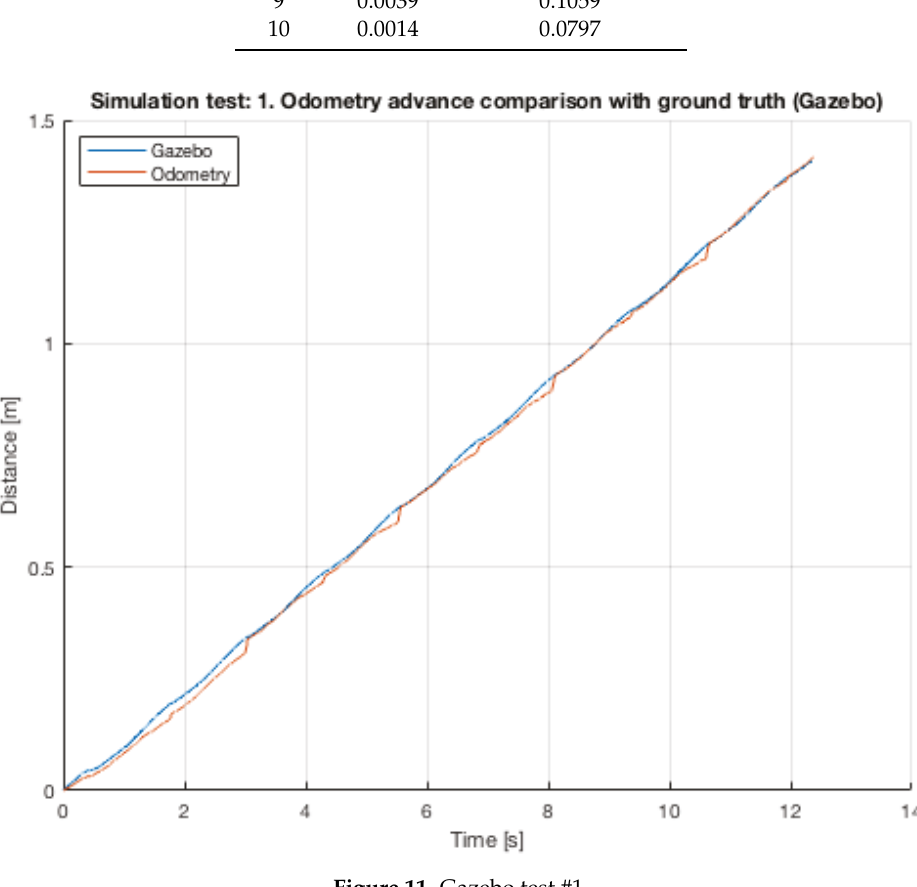
Figure 11. Gazebo test #1.